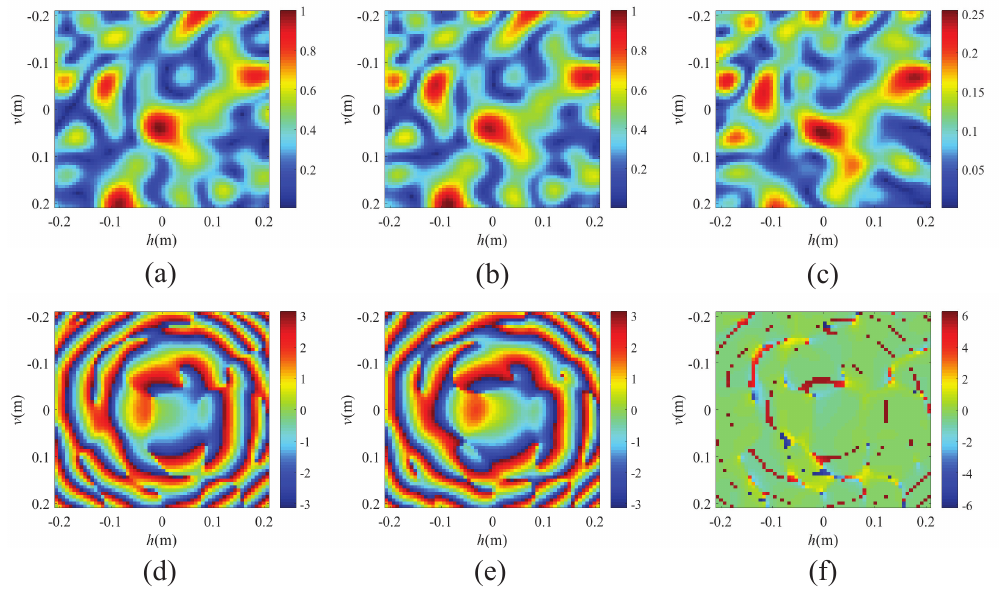
Figure 3. Effect of phase error on amplitude and phase of the measurement matrix: ( a ) amplitude without phase error; ( b ) amplitude with phase error; ( c ) amplitude difference of the radiation field; ( d ) phase without phase error; ( e ) phase with phase error; ( f ) phase difference of the radiation